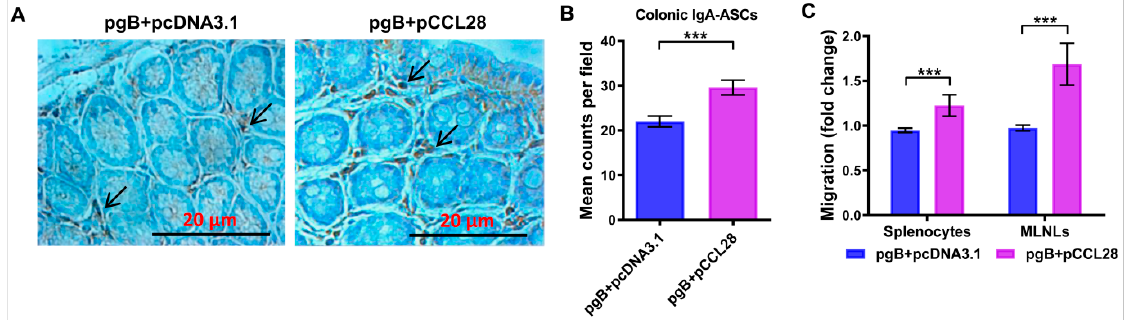
Figure 5. Recruitment of immunocytes mediated by the CCL28 adjuvant in tissues. ( A ) Comparison of IgA + cells at the colorectal mucosal sites of immunized mice (magnification: ×200). Murine colorectal samples ( n = 5/group) were collected on day 14 post boost, and IgA + cells were detected by immunohistochemistry. The colorimetric reaction was developed with diaminobenzidine and counterstained with H&E. The arrows indicate IgA + cells. ( B ) Quantification of IgA + cells by counting five high-power fields for each colorectal sample. Data are expressed as the means of IgA + cells ± SEMs for each group. ( C ) Chemotactic splenocytes and MLNLs of immunized mice in response to murine CCL28 protein. On day 14 post boost, the splenocytes and MLNLs (1 × 10 7 /mL) were prepared and counted and used to assess the chemotactic activities recruited by CCL28 protein using a Transwell system. The migrated cells in the lower chamber were counted after 2 h incubation. Fold changes were calculated by comparing with the number of cells in the lower chamber without CCL28 protein. Data are expressed the means of migrated cell fold changes ± SEMs for each group. *** p < 0.001, antigen group compared to pgB + pCCL28 (5 μ g) group, as determined by nonparametric Student’s t -test.